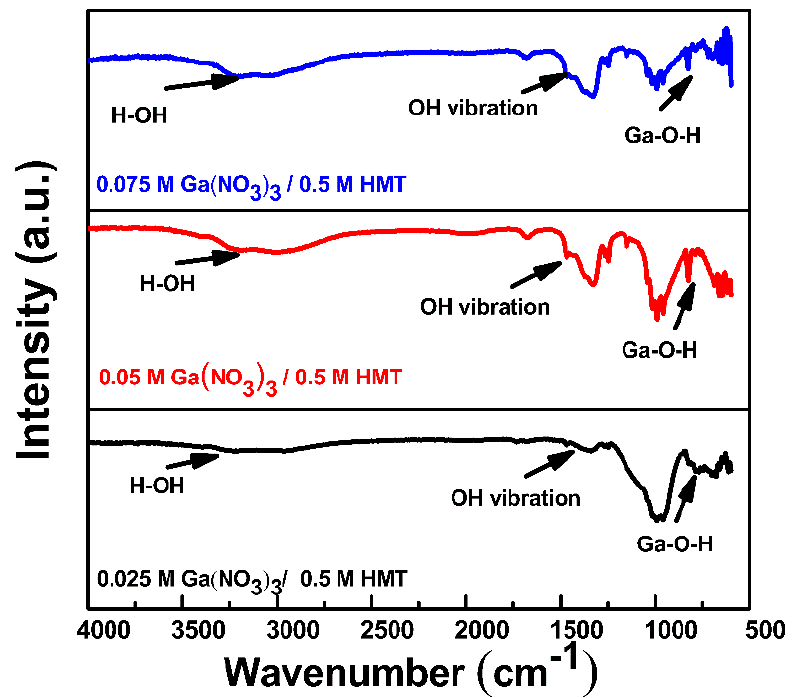
Figure 3. FTIR spectra of GaOOH prepared from Ga(NO 3 ) 3 at various concentrations.